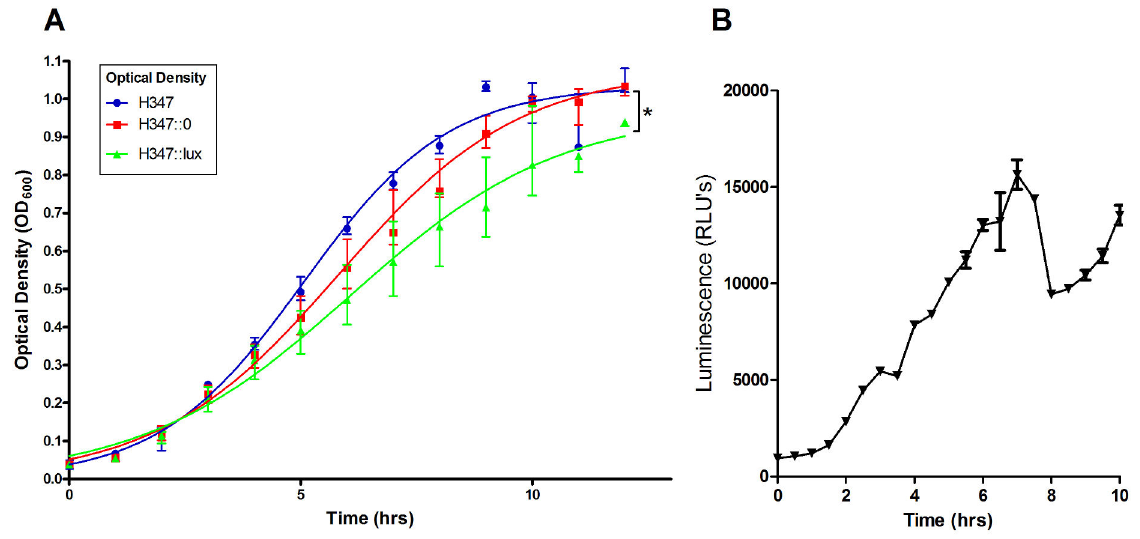
Figure 3. The effect of bioluminescence expression on in vitro growth. S. pyogenes strain H347::lux was cultured over a 10 hour period alongside the isogenic strains H347 and H347::0. Logistic curves were fitted to the data (A, n=6 per group, from experiments performed on two separate days, Linear Regression r 2 >0.95, * p <0.05). Luminescence of H347::lux was quantified during growth (B) Error bars indicate median and interquartile range.